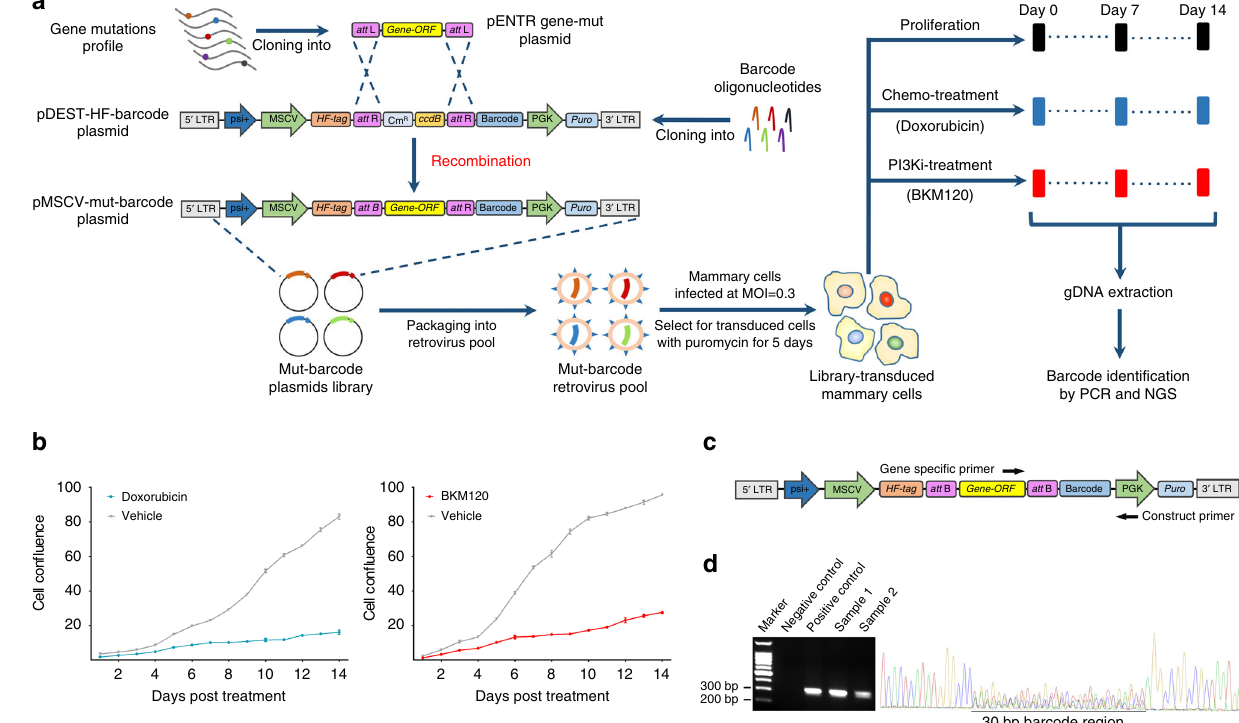
Fig. 2 Design of the recombination-based mutation barcoding (ReMB) library and its application to functional screening. a The design of the ReMB library and its screening schema are illustrated. We constructed a series of donor clones containing the gene-coding sequences of wild-type or various mutations according to the mutation pro fi les of the TCGA, COSMIC, and FUSCC cohorts. A retroviral pDEST-HA-Flag vector was used to construct the barcode plasmids. Random 30-bp annealed oligonucleotide pairs were inserted into this retroviral backbone. We then constructed a set of vectors containing various barcodes with one barcode in each vector. The recombination reaction was performed for a retroviral mutation plasmid that contained a unique barcode sequence. All of the clones were mixed into a pool to package a gene mutations retrovirus library that included mutants, wild-type and negative controls. The gene mutation library was delivered into MCF-10A or HEMC cells by retroviral infection at an MOI of 0.3. Cells stably expressing the mutated genes were obtained by puromycin selection for 5 days. Functional screens were conducted for 2 weeks to examine proliferation, doxorubicin, and BKM120 responses, followed by PCR ampli fi cation of the barcode sequences that were integrated into the chromosomes. The puri fi ed PCR products were subjected to barcode deconvolution analysis using NGS. b Growth curves were obtained for transduced MCF-10A cells that were exposed to concentrations